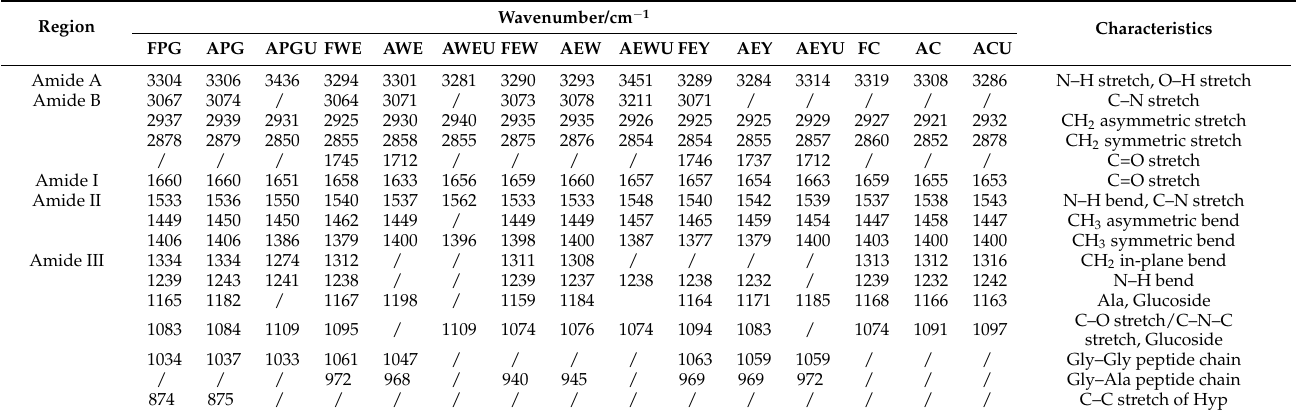
Table 3. The absorbance characteristics of the five fresh and aged binders.